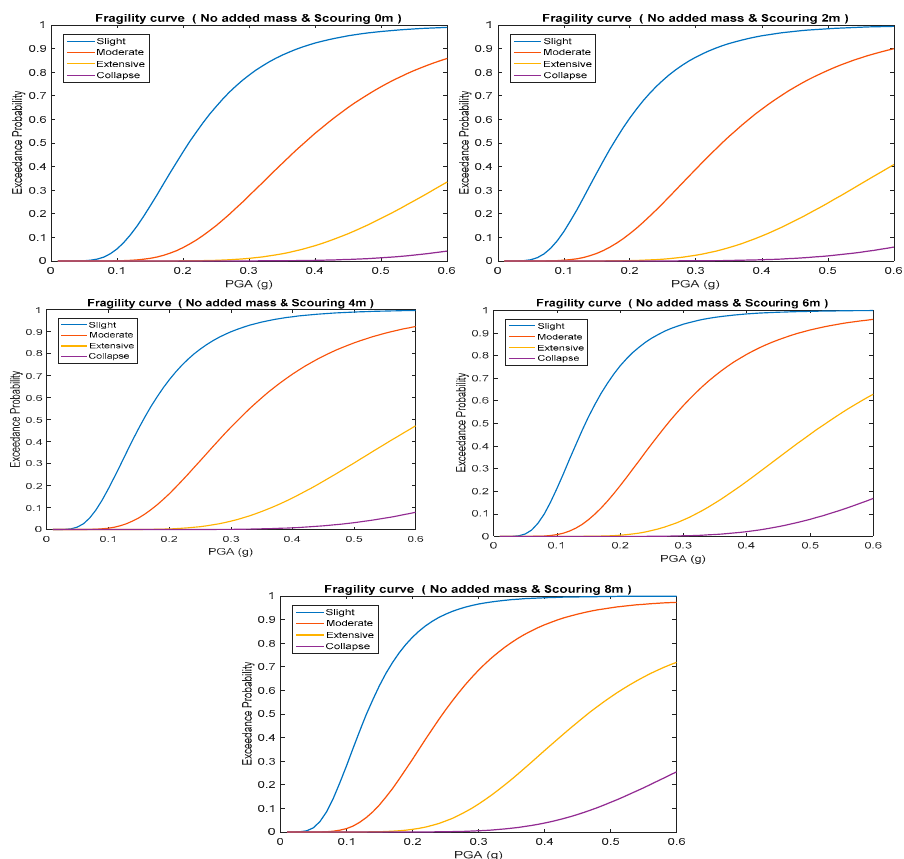
Figure 17. Fragility curves of each performance level under 0 m bridge water level and the same scouring depth.